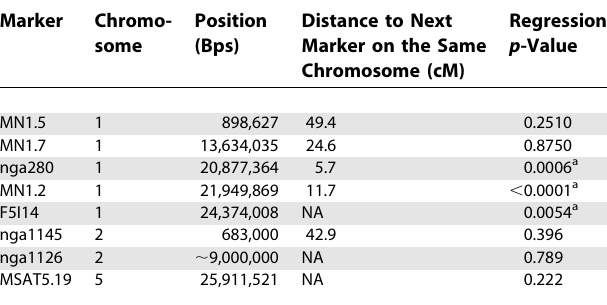
Table 1. Analysis of the Relationship between Marker Genotype and ASI in the CWW F 2